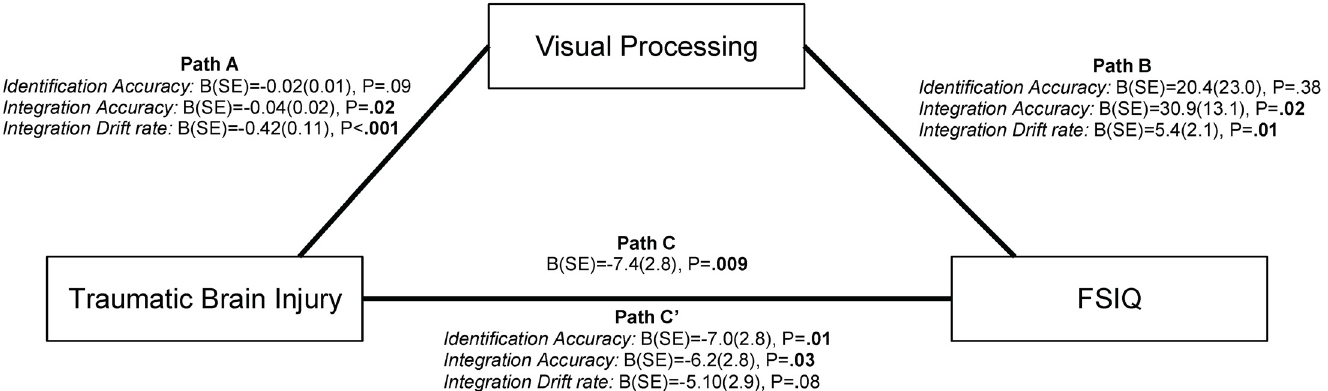
Fig 3. Mediation analysis investigating the roles of visual identification and visual integration in the relation between intelligence impairments and TBI. Note . The mediation analysis describes the relations between: (1) group membership and full-scale IQ (FSIQ, Path C); (2) group membership and Visual Integration Test performance (identification accuracy, integration accuracy and integration drift rate , Path A); (3) Visual Integration Test performance and FSIQ (Path B); and (4) group membership and FSIQ, corrected for Visual Integration Test performance (Path C ’